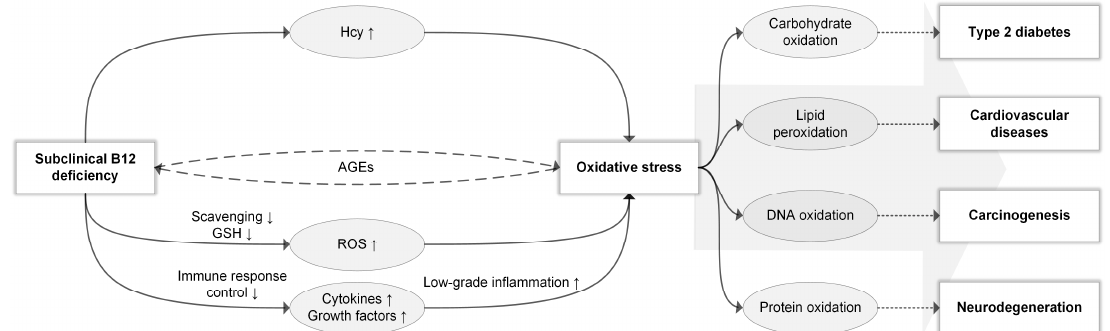
Figure 1. Subclinical B12 deficiency in relation to oxidative stress. Subclinical B12 deficiency might induce oxidative stress through: Hcy accumulation; reduction of ROS scavenging and indirect reduction of GSH; reduction of immune response control by modulating cytokine and growth factor expression with subsequent low-grade inflammation; a positive feedback cycle through advanced glycation end-products (AGEs), where B12 deficiency induces AGE formation through oxidative stress and AGEs reduce B12 uptake. Oxidative stress-induced carbohydrate oxidation has been implicated in type 2 diabetes, lipid peroxidation in cardiovascular diseases, DNA oxidation in carcinogenesis, and protein oxidation in neurodegeneration. However, such associations likely constitute only part of the complicated role of oxidative stress in the pathophysiology of age-related diseases. As indicated by the large arrow, different oxidation substrates are likely synergistically responsible.